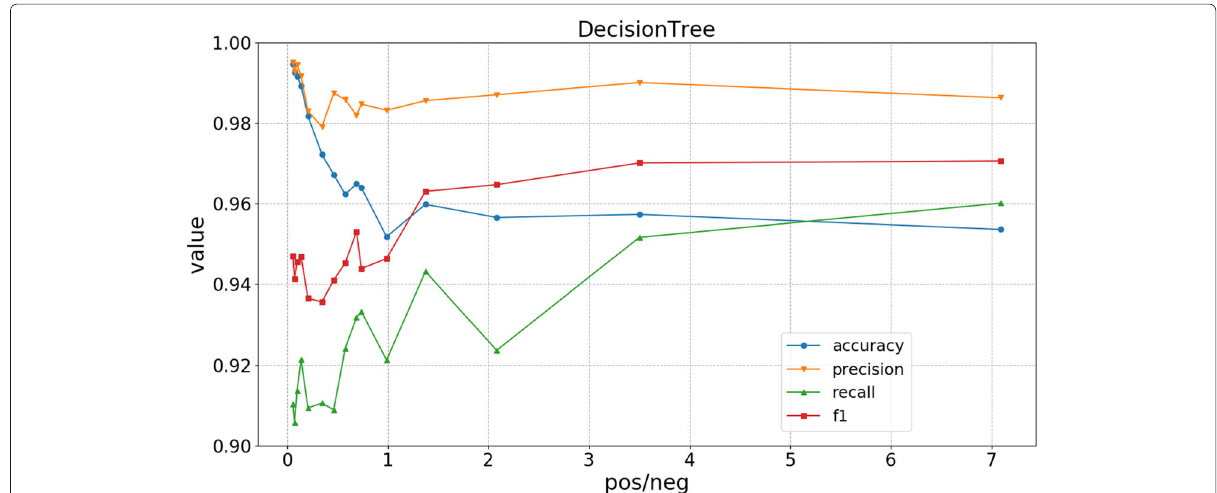
Fig. 8 Result of DT with different ratios of positive/negative samples. We tested the Decision Tree classifiers using the following positive/negative ratios: 7.089, 3.499, 2.081, 1.375, 0.988, 0.727, 0.462, 0.346, 0.278, 0.139, 0.099, 0.075, and